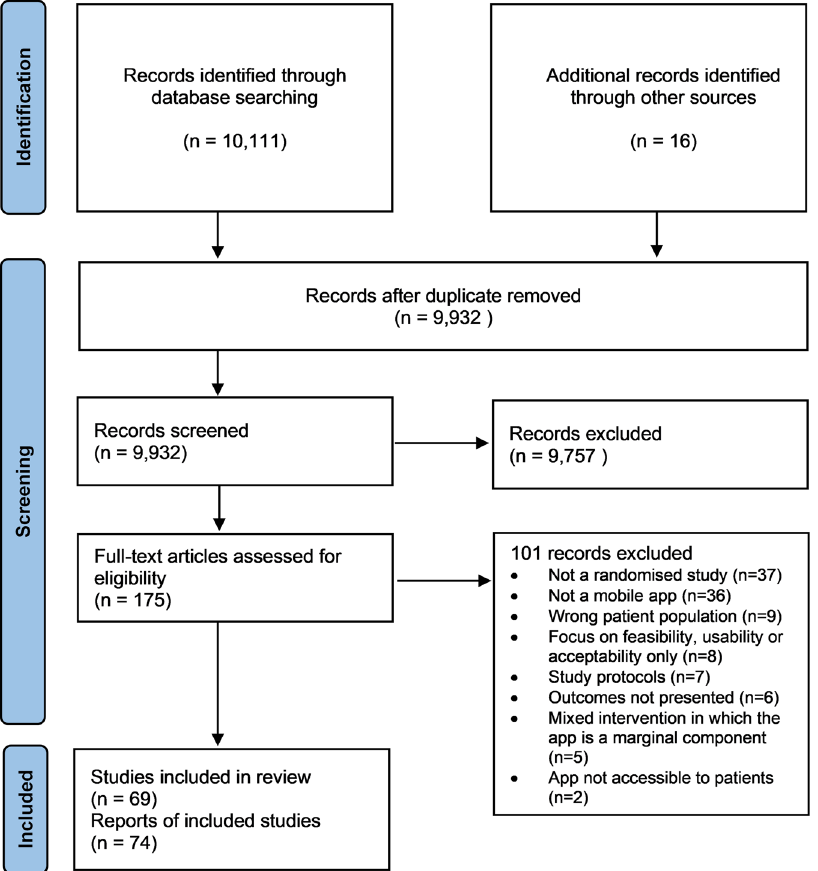
Fig. 1 Study selection fl ow diagram. Modi fi ed Preferred Reporting Items for Systematic Reviews and Meta-Analyses (PRISMA) fl ow diagram of the article selection